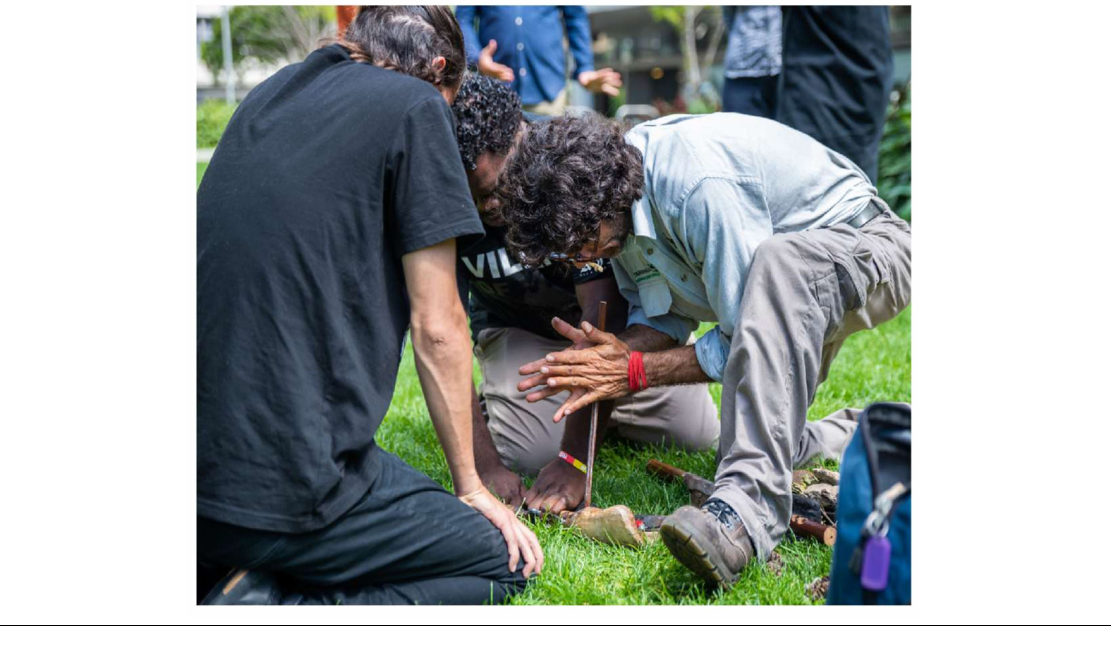
Figure 4. Preparing for the Smoking Ceremony on Gadigal Land, UTS Alumni Green in November 2018 (Source: photograph by Kwa Nguyen)